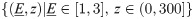
Complex dynamics of model (4).Top row: parametric portrait of the qualitative dynamics of model (4) in the domain {(E_,z)|E_∈[1,3],z∈(0,300]} at r = 1, w = 1.5, p = 0.1, E¯=4, ε = 0.05. White areas show the parameter regions in which only one fixed point, (5), was detected. This fixed point is an attractor. The blue region bordering the white one corresponds to the case in which fixed point (5) becomes a repeller and the second equilibrium, (6), emerges. Equilibrium (6) is locally asymptotically stable. Green areas are the domains in which an attracting periodic orbit was detected. Red and violet domains correspond to regions where complex chaotic-like dynamics were observed. Black stars, *, indicate observed co-existence of multiple attractors. Inlet linked to the gray area shows theoretical estimates of transition boundaries (dashed blue and green lines) relative to the ones observed in experiments. A,B,C,D,E,F: typical dynamics observed in the corresponding parametric regions.